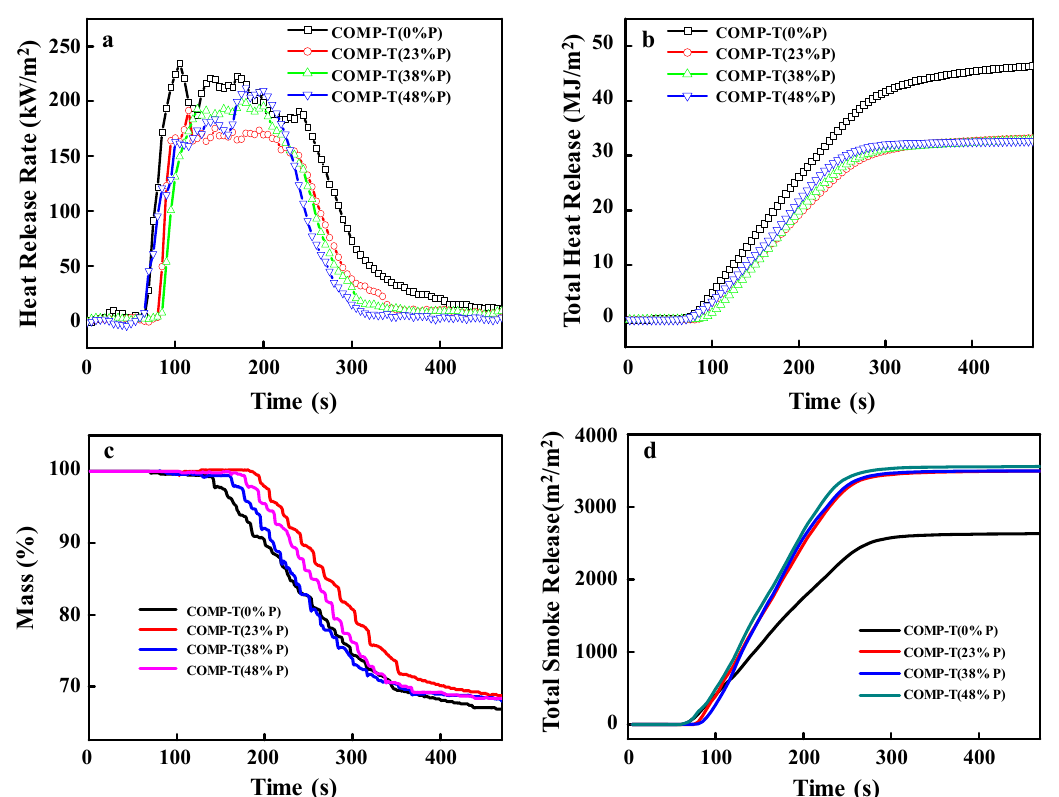
Figure 6. ( a ) Heat release rate, ( b ) total heat release, ( c ) mass loss, and ( d ) total smoke release for the RTM epoxy composites preformed by the ET3228 tackifiers with a MRP content in the range of 0 to 48 wt.%.